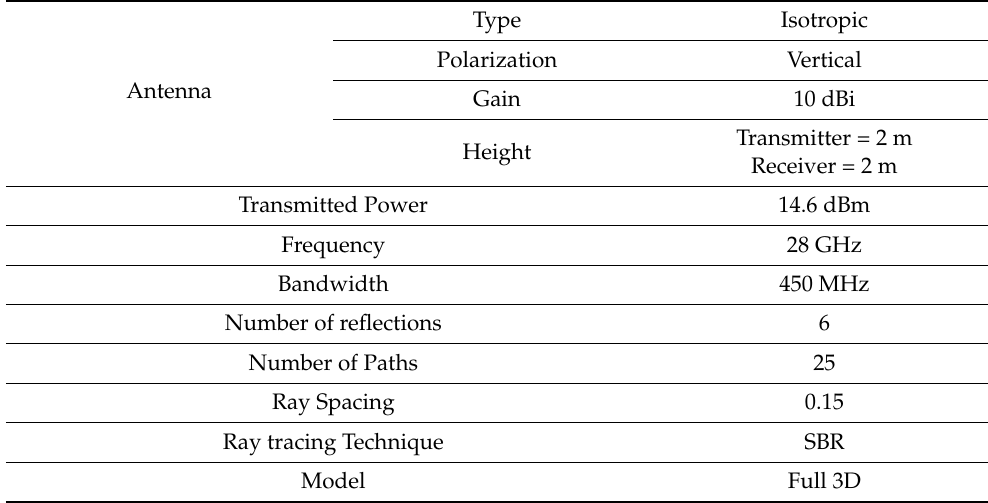
Table 2. V2V configuration